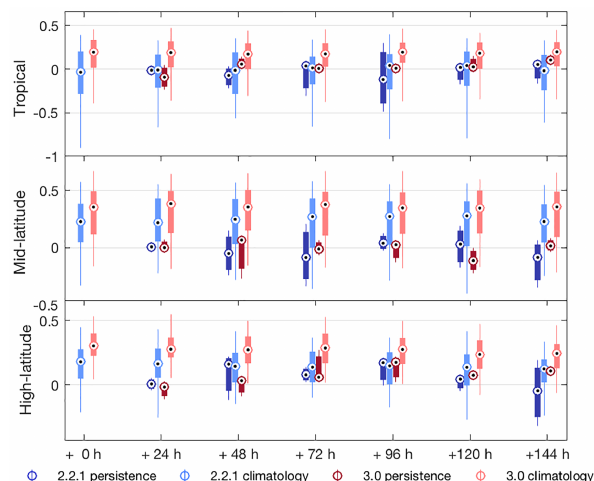
Figure 6. Model climatology skill and persistence skill for Ocean- MAPS 2.2.1 (blue) and OceanMAPS 3.0 (red). The 5th and 95th percentiles are shown by the whiskers, while the middle quartiles are shown by the boxes. Data have been binned into tropical (16 ◦ N to 20 ◦ S), mid-latitude (20 to 45 ◦ S) and high-latitude (45 to 75 ◦ S)